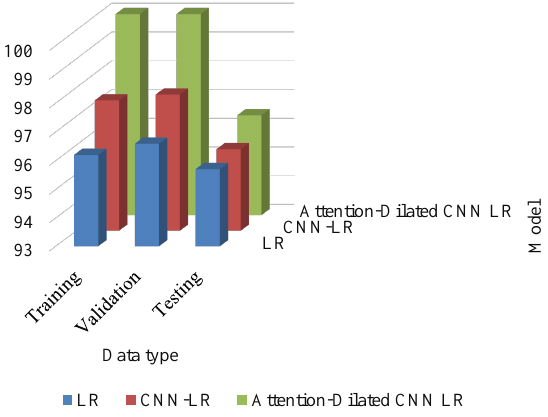
Figure 8. The training, validation, and testing performance of ADCLR model.